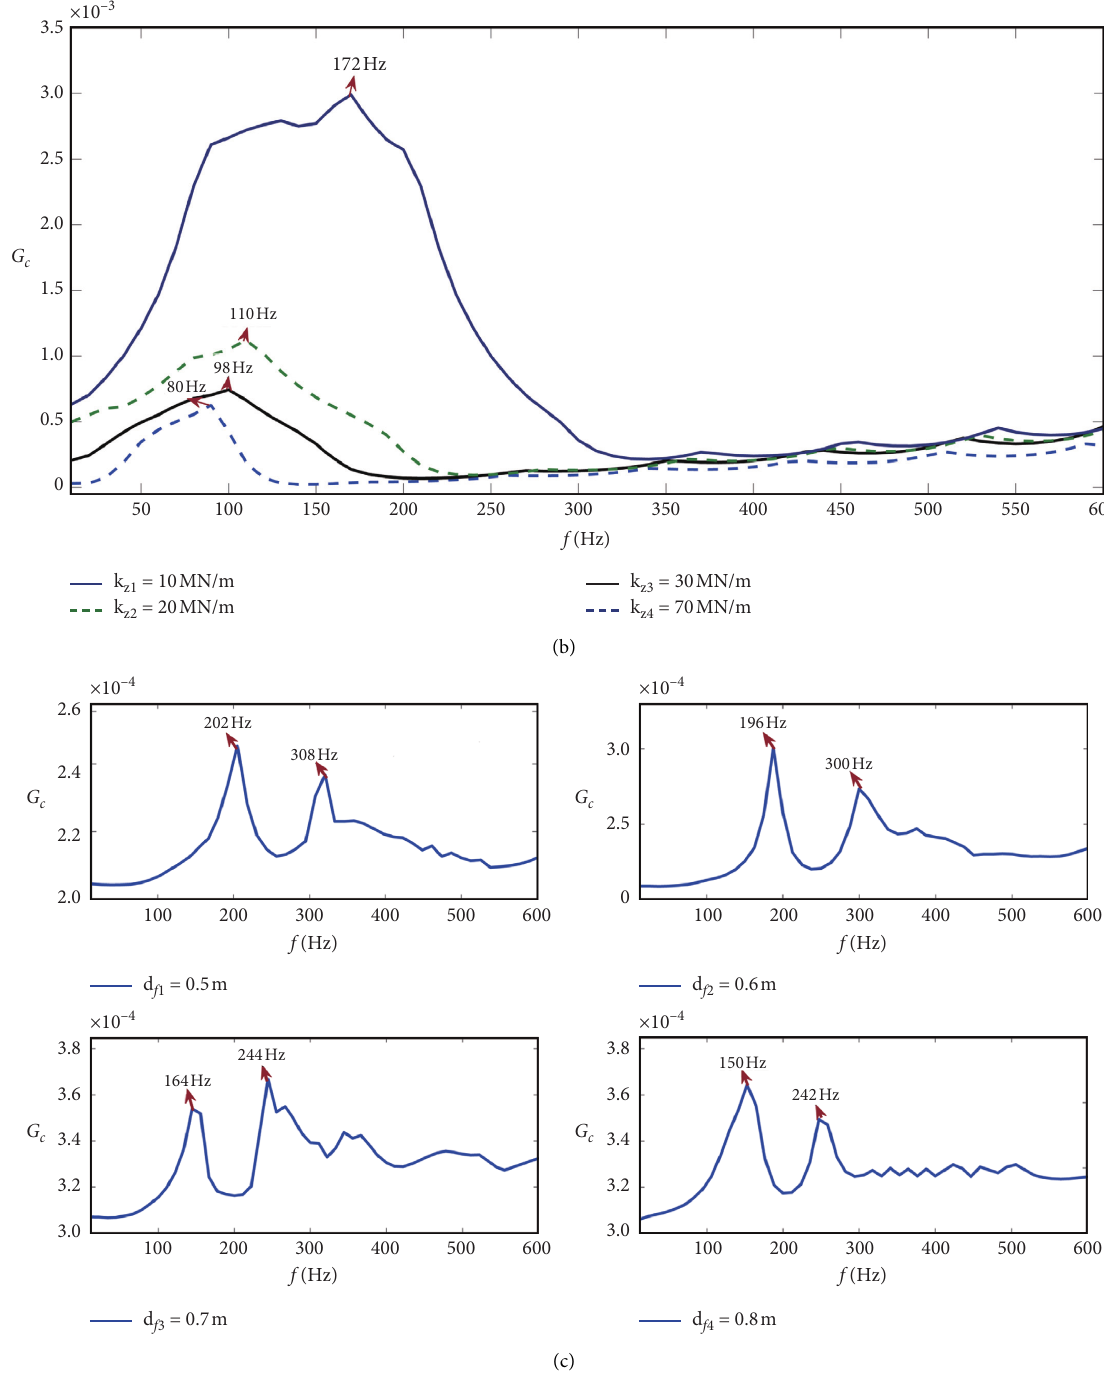
Figure 6: Growth curve of the corrugation on different curved tracks. (a) Corrugation growth curve of curved rail with different radius. (b) Corrugation growth curve of curved rail with different support stiffness. (c) Corrugation growth curve of curved rail with different sleeping